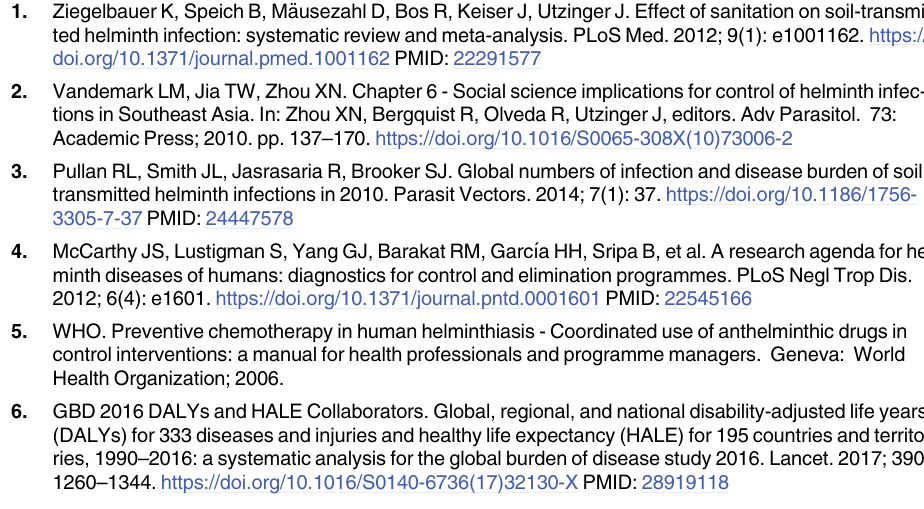
S1 Fig. Reported open defecation practices. Multiple choice question that was asked to one adult household member per screened